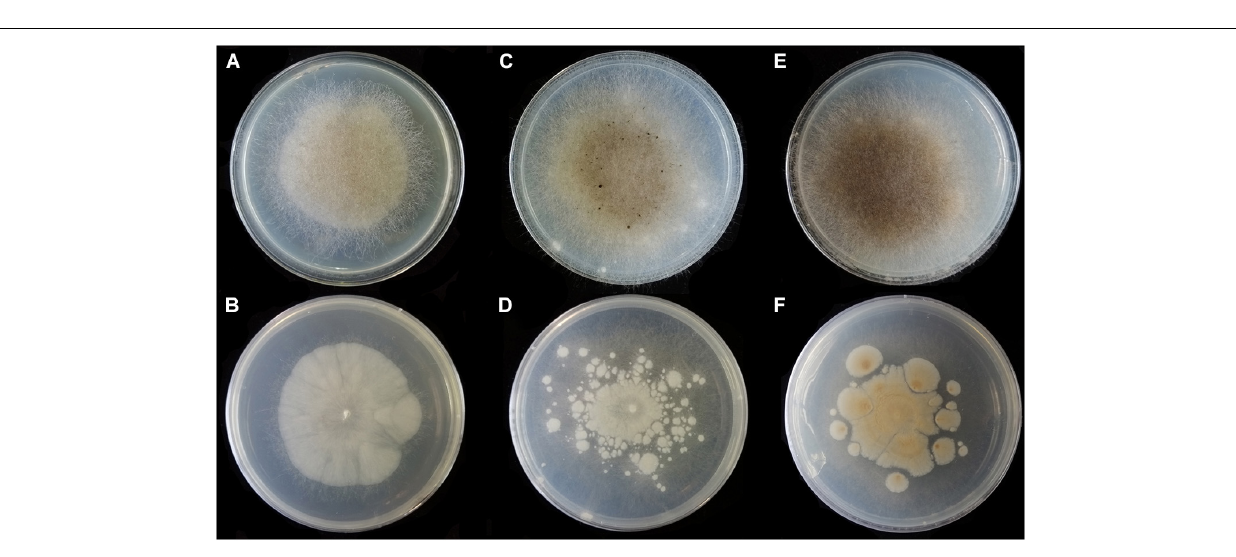
Media and temperatures: Colonies on SMA, rough around the edges, concentric ring-shaped, attaining 69-mm diameter after 8 days at 27 ◦ C, white. Colonies on PDA, regularly wavy zonate, attaining 72-mm diameter after 7 days at 27 ◦ C, white at first and then lime green (R31). No growth at 38 ◦